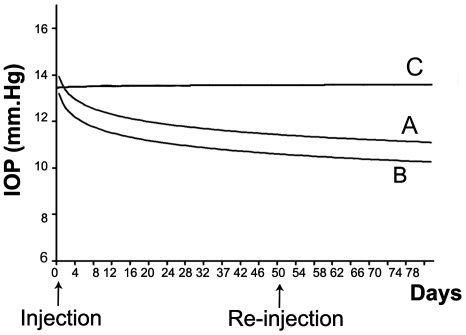
Comparison of intraocular pressure (IOP) between topical latanoprost eyedrop, subconjunctival latanoprost liposome and latanoprost-free blank liposomes.Group A: topical latanoprost eye drop. Group B: subconjunctival latanoprost liposome. Group C: latanoprost-free blank liposomes.